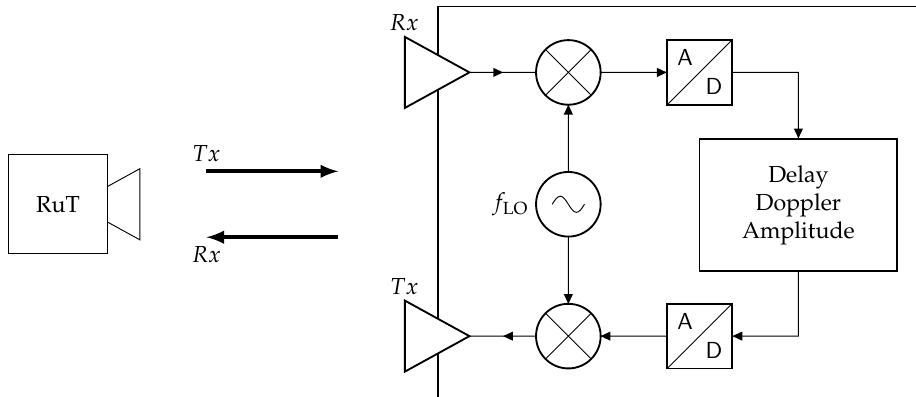
Figure 5. The digital radar target simulator